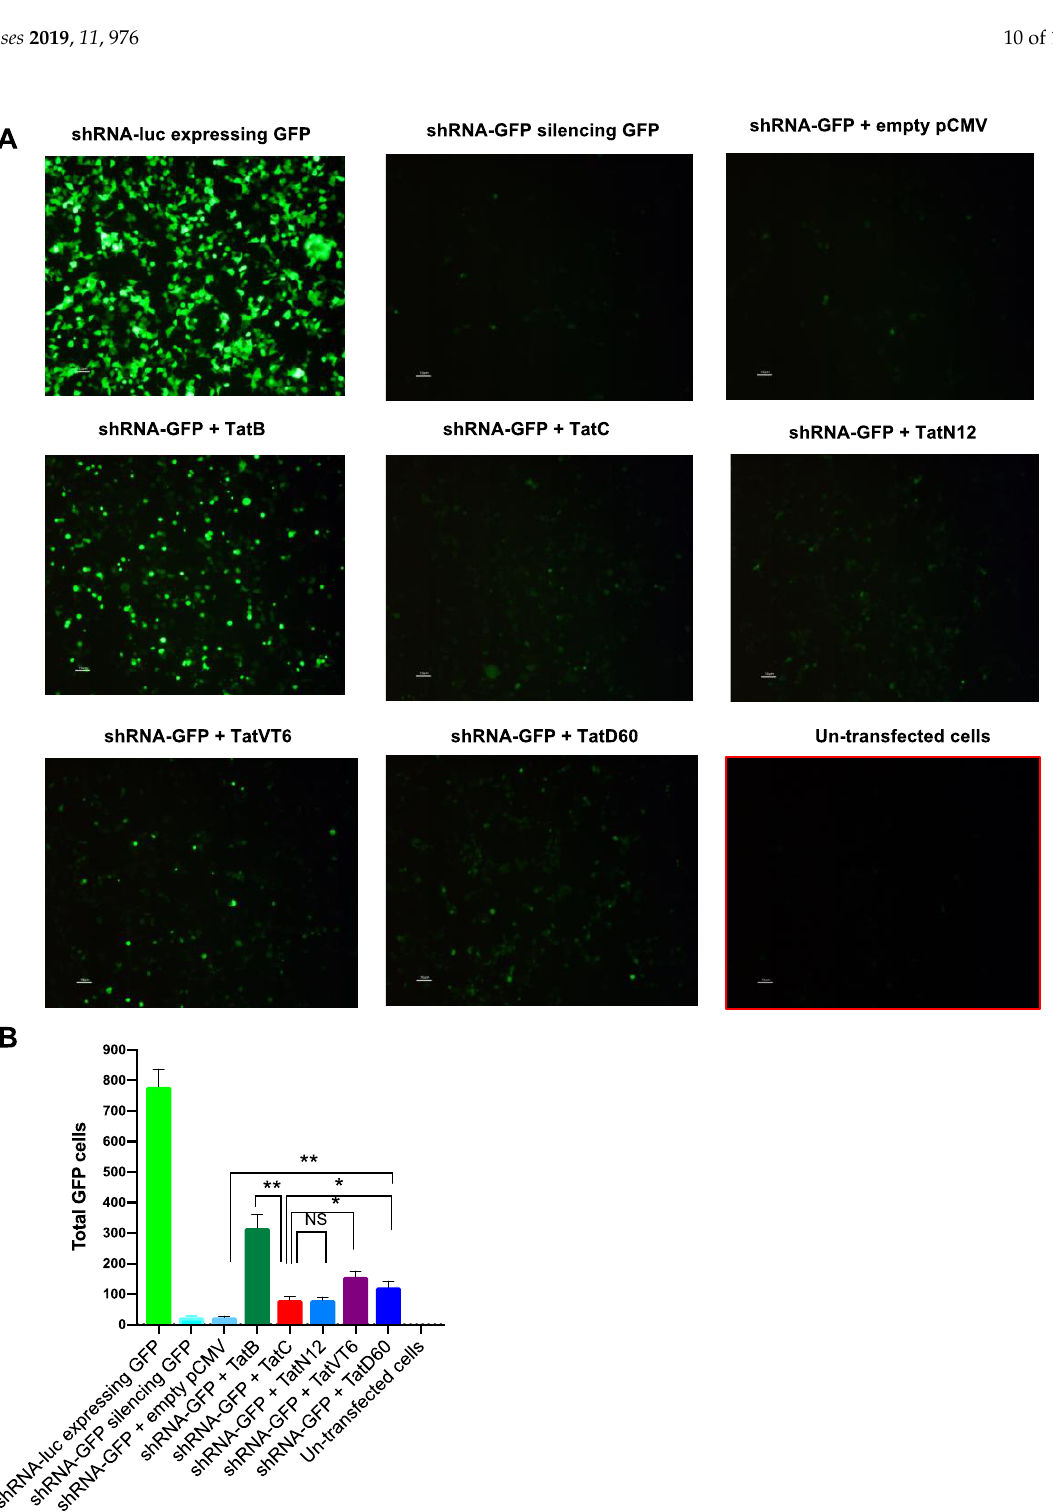
Figure 3. shRNA suppressor activity of Tat variants and subtypes by microscopy. Panel ( A and B ) HEK293T cells (1 µ g plasmid DNA / well in 1 × 10 6 cells) were co-transfected with shRNA-GFP (0.5 µ g in 1 mL) and Tat variants (TatN12 or TatVT6 or TatD60) or Tat subtypes (TatB or TatC) or empty